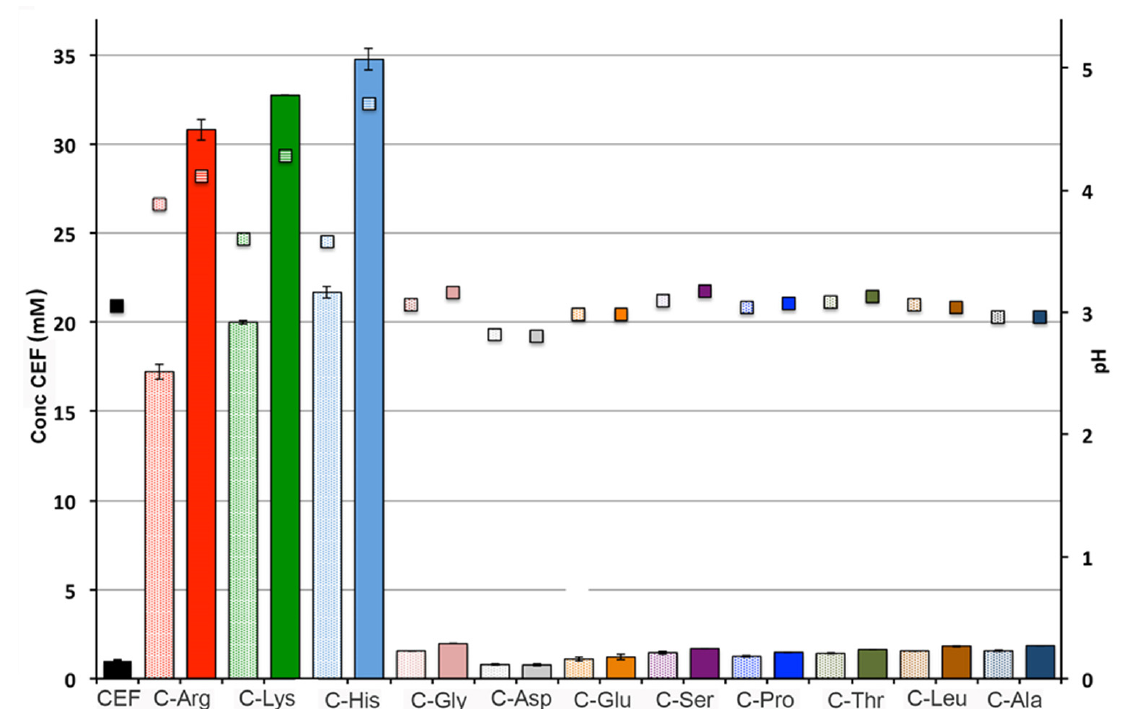
Figure 3. Aqueous solubility in water at 25 °C of CEF, alone or as a binary mixture with the different AA in the 1:1 (dotted bars) and 1:2 (full bars) molar ratios.